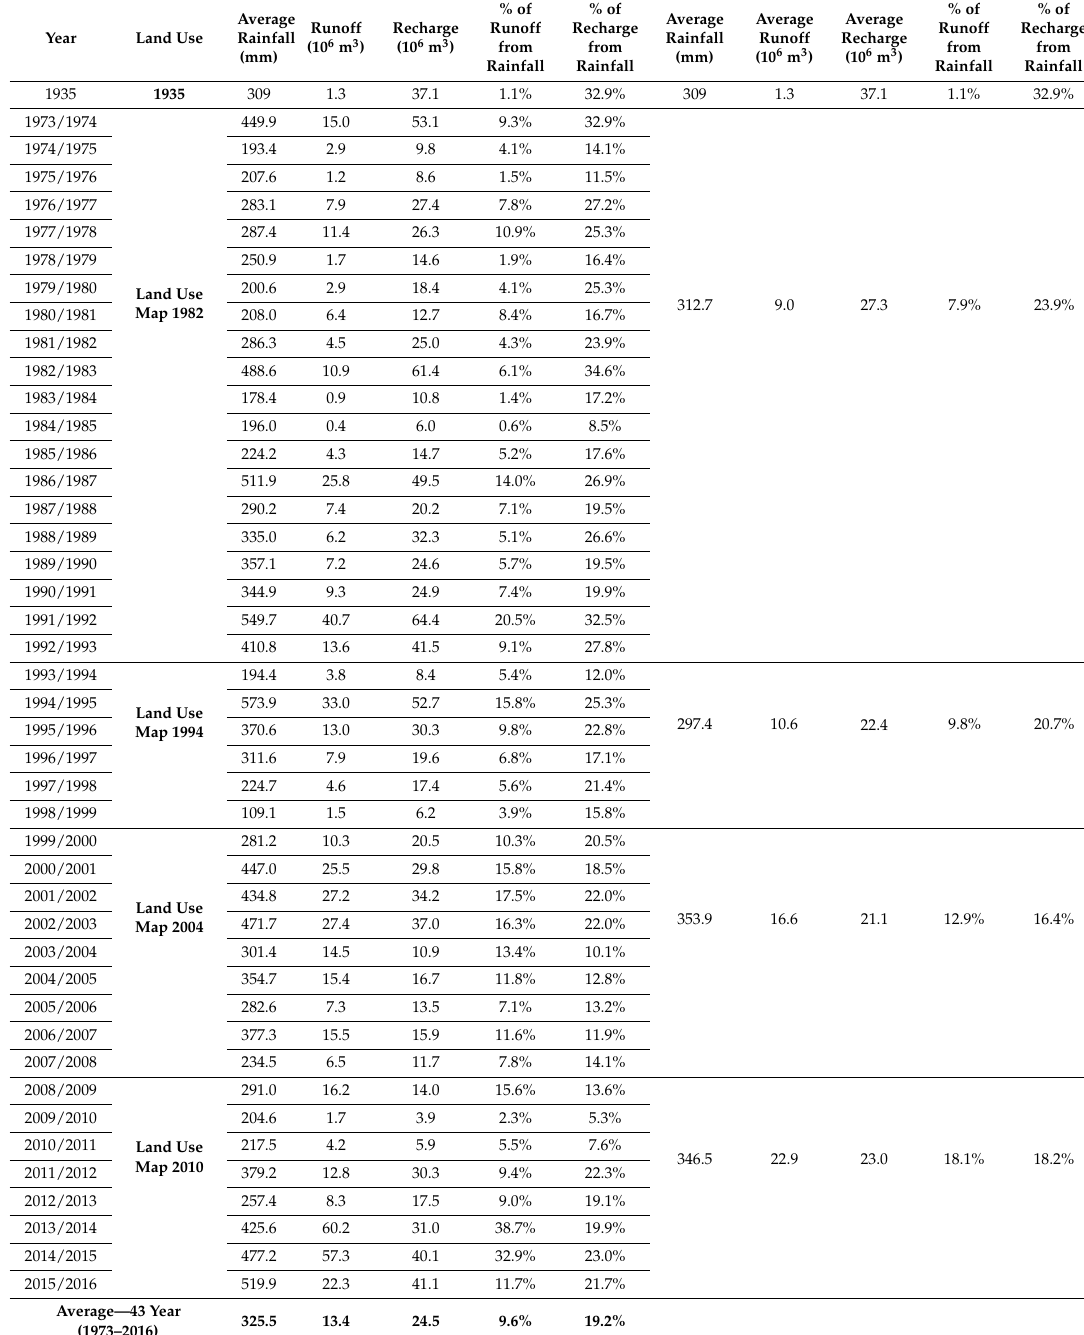
Table 5. Rainfall, runoff and recharge over the Gaza Strip for 1935 and from 1973 to 2016 using GRID